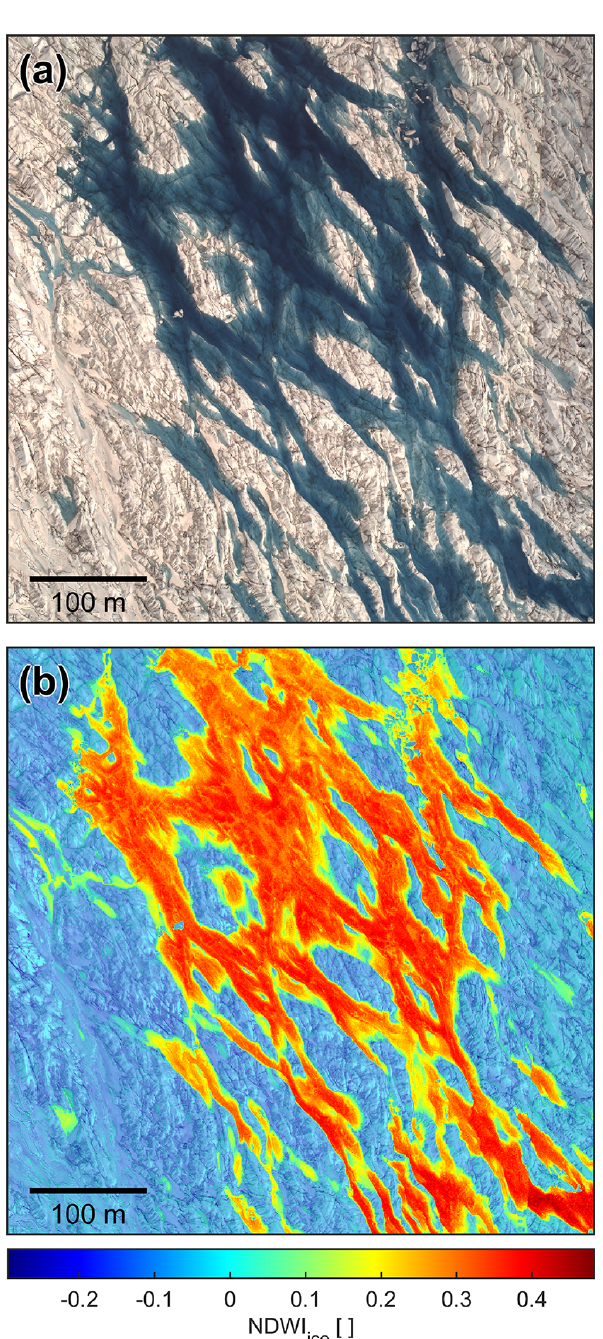
Figure 3. (a) Mosaic of three geolocated, orthorectified CAMBOT natural color images of water-filled crevasses on Sermeq Kujalleq (Jakobshavn Isbræ) on 15 May 2019. (b) NDWI ice plotted over CAMBOT image mosaic with NDWI ice pixels below the detection threshold of 0.05 shown at 50% opacity. For location see Fig.